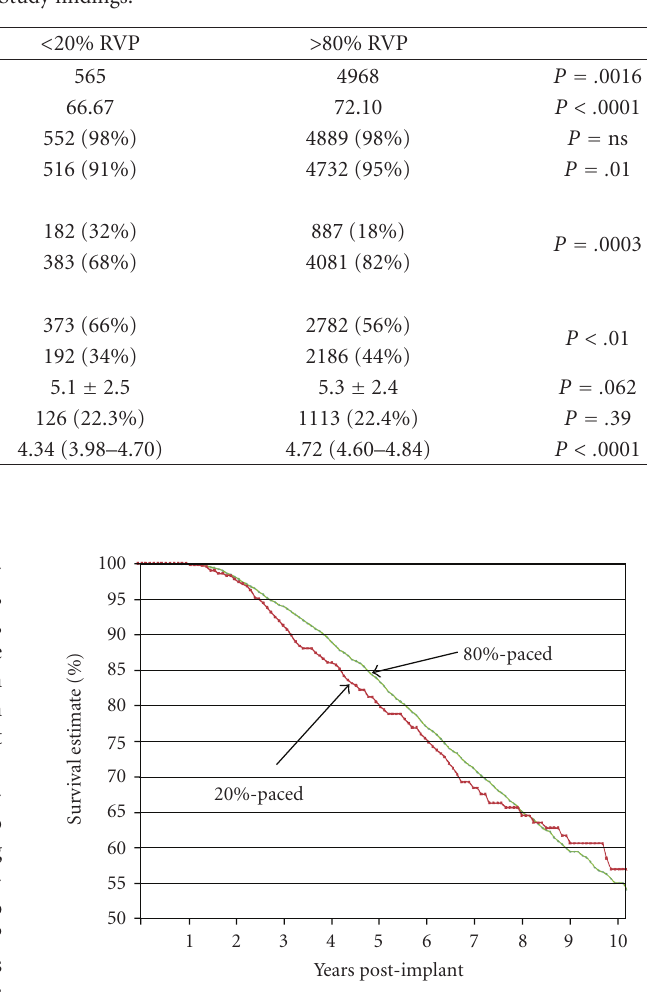
Figure 3: Survival function for < 20% versus > 80% RVP. Although Kaplan-Meier analysis did not find a significant di ff erence between these groups when they were examined without covariates, Cox regression analysis controlling for age at implant, pacemaker type, and rate responsiveness showed that overall survival was better for those veterans with > 80% RVP ( P = . 0016). Lower age, dual- chamber pacemaker, and rate responsiveness were associated with better survival. Most of the di ff erence in risk occurs between years 3 and 8 post implant. There is little di ff erence prior to year 2.